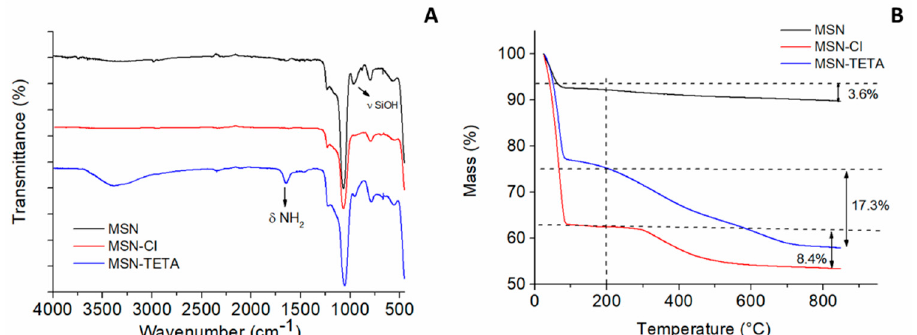
− Cl and MSN − TETA.